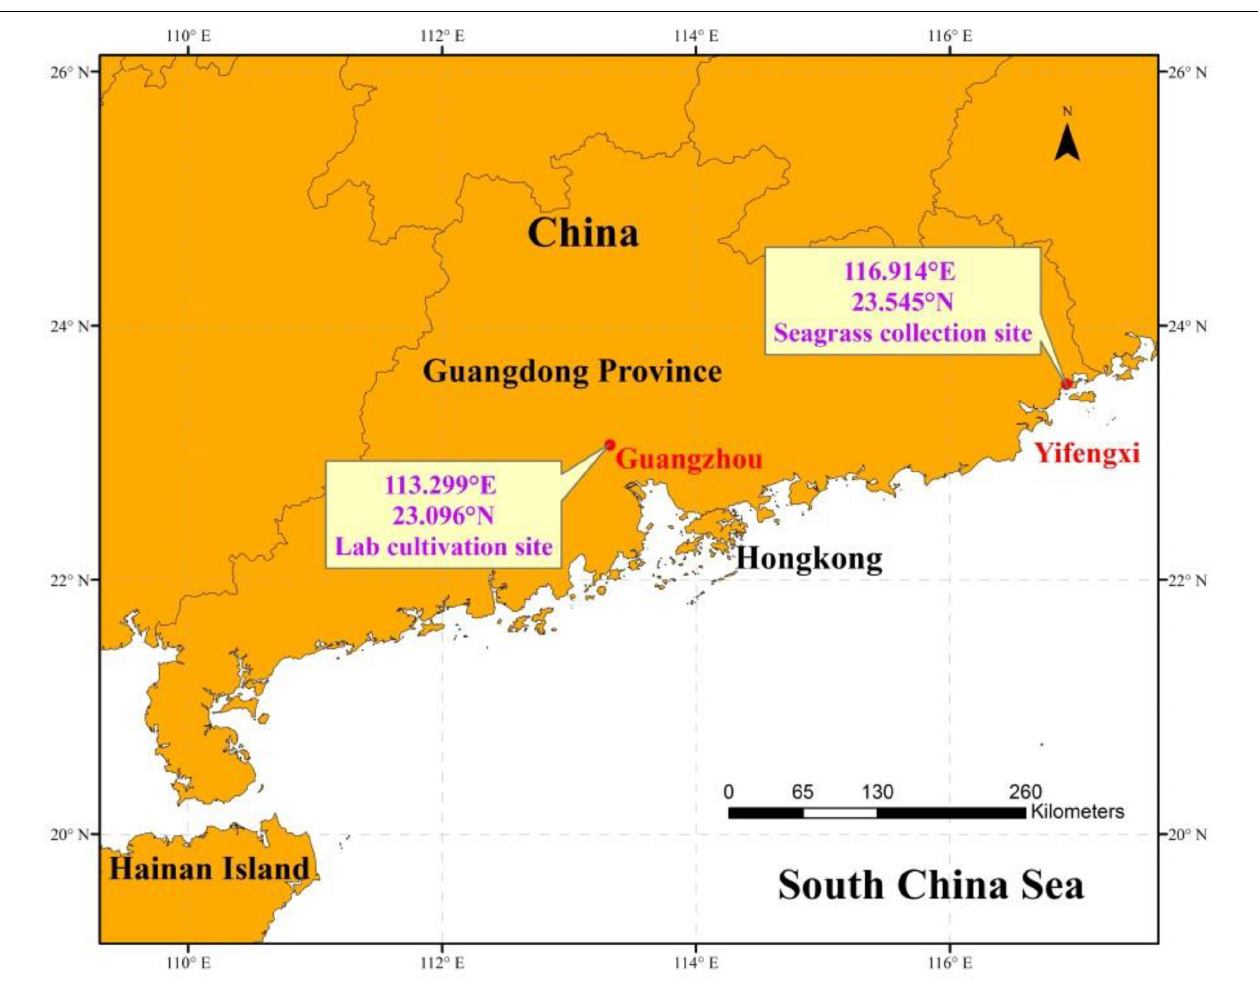
FIGURE 1 | Location of seagrass collection and laboratory